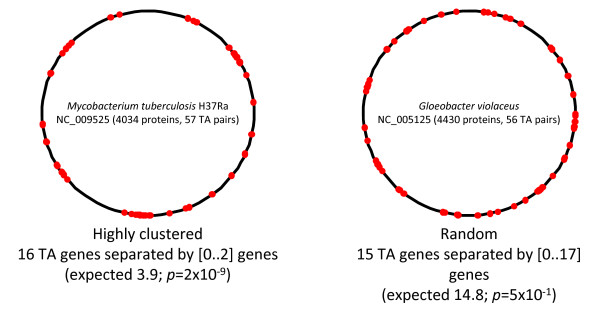
TAS in selected genomes. Red dots show the approximate position of TAS genes on the circular chromosomes.